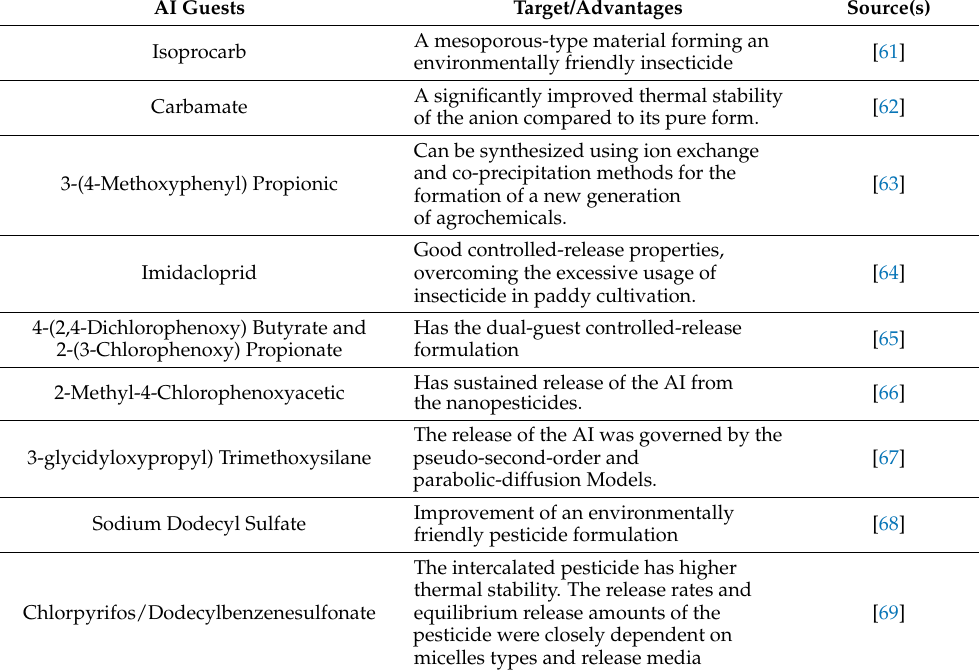
Table 4. Nanopesticides synthesized using host–guest supramolecular chemistry using zinc-layered hydroxide as the host and various AIs as the guest for various targets and advantages. AI Guests Target/Advantages Source(s)